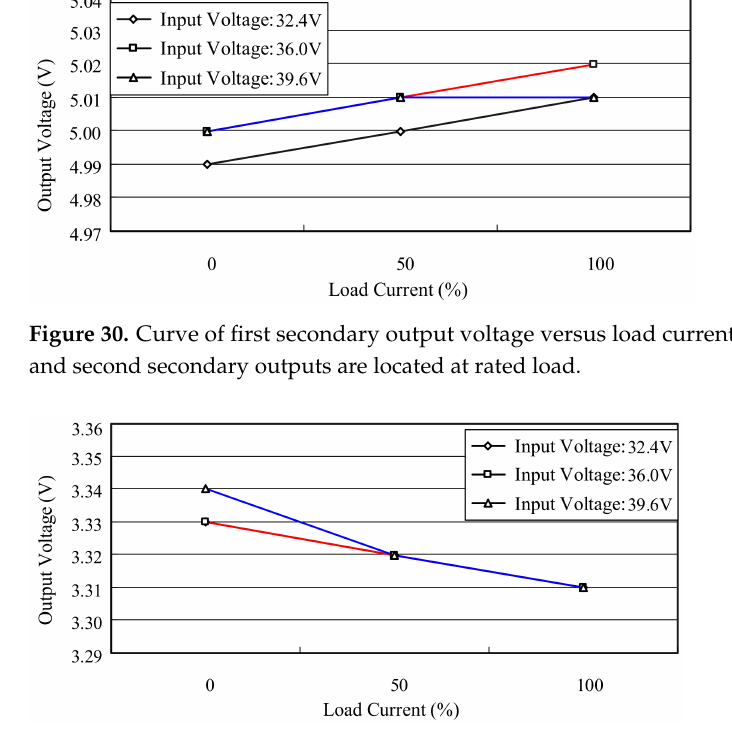
Figure 31. Curve of second secondary output voltage versus load current on condition that the main and first secondary outputs are located at rated